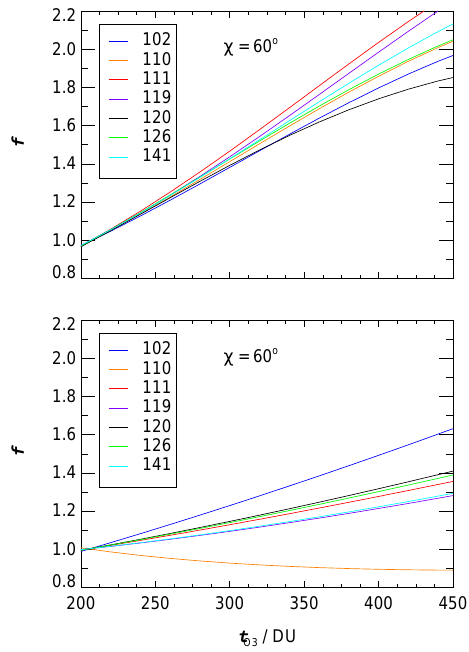
) according to Eq. (5) for all Figure 6. Correction factors f (χ,t O 3 FR instruments as a function of total ozone column at a fixed solar zenith angle of 60 ◦ . Upper and lower panels show correction factors for old and new interference filters, respectively. Figure 7. Examples of TUV simulated action spectra for three dif- ferent solar zenith angles of 30 ◦ (upper panel), 60 ◦ (middle panel) and 80 ◦ (lower panel) at a total ozone column of 350DU. The j (O 1 D) correspond to the integrals underneath the black curves. D rel F λ curves, scaled for matching integrals, correspond to old and new spectral sensitivities of FR 141 in red and blue, respectively. Note that the scales in the upper/middle and the lower panel differ by 2 orders of magnitude and that the wavelength range of the lower panel was extended to indicate the secondary peak in the red curve around